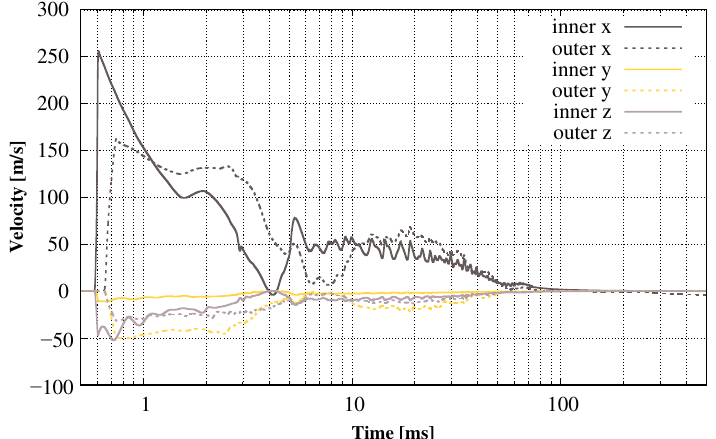
Figure 9. Velocity distribution along axes and